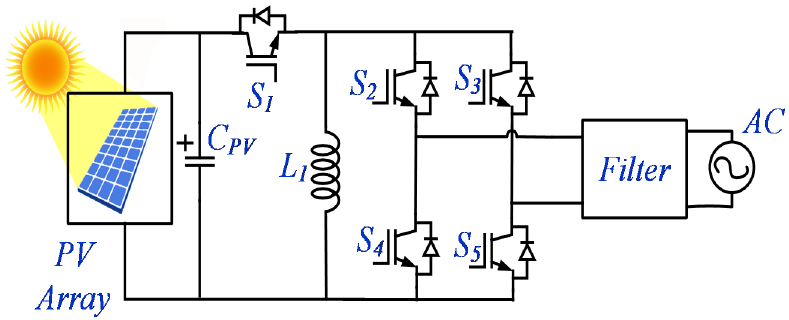
Figure 15. Integrated buck-boost inverter.